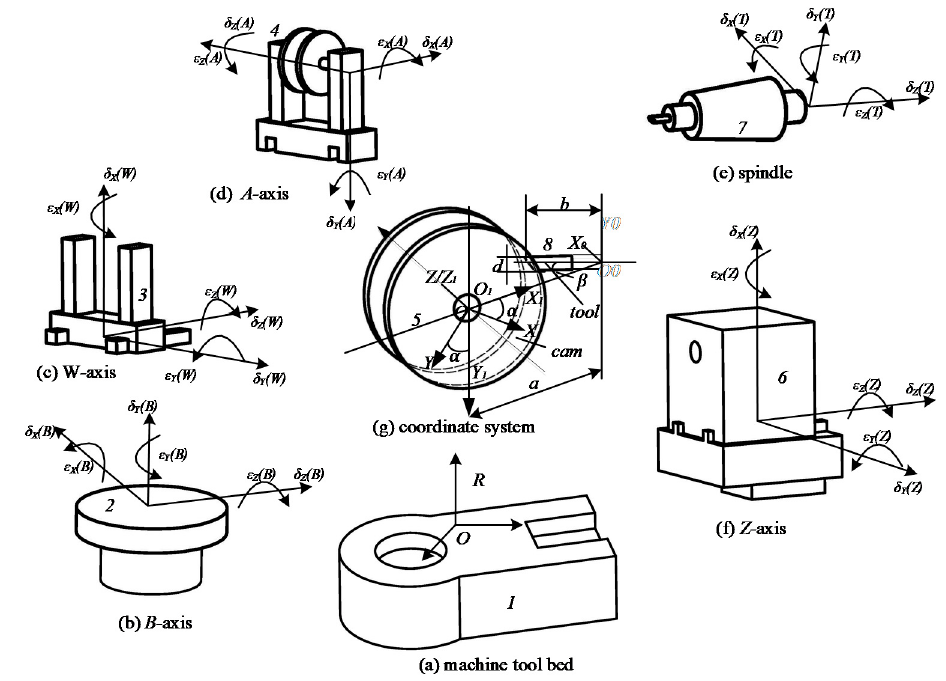
Figure 3. Topology and structure of the machine tool. ( a ) Machine tool bed; ( b ) B -axis; ( c ) W -axis; ( d ) A -axis; ( e ) Spindle; ( f ) Z -axis; ( g ) Coordinate system.